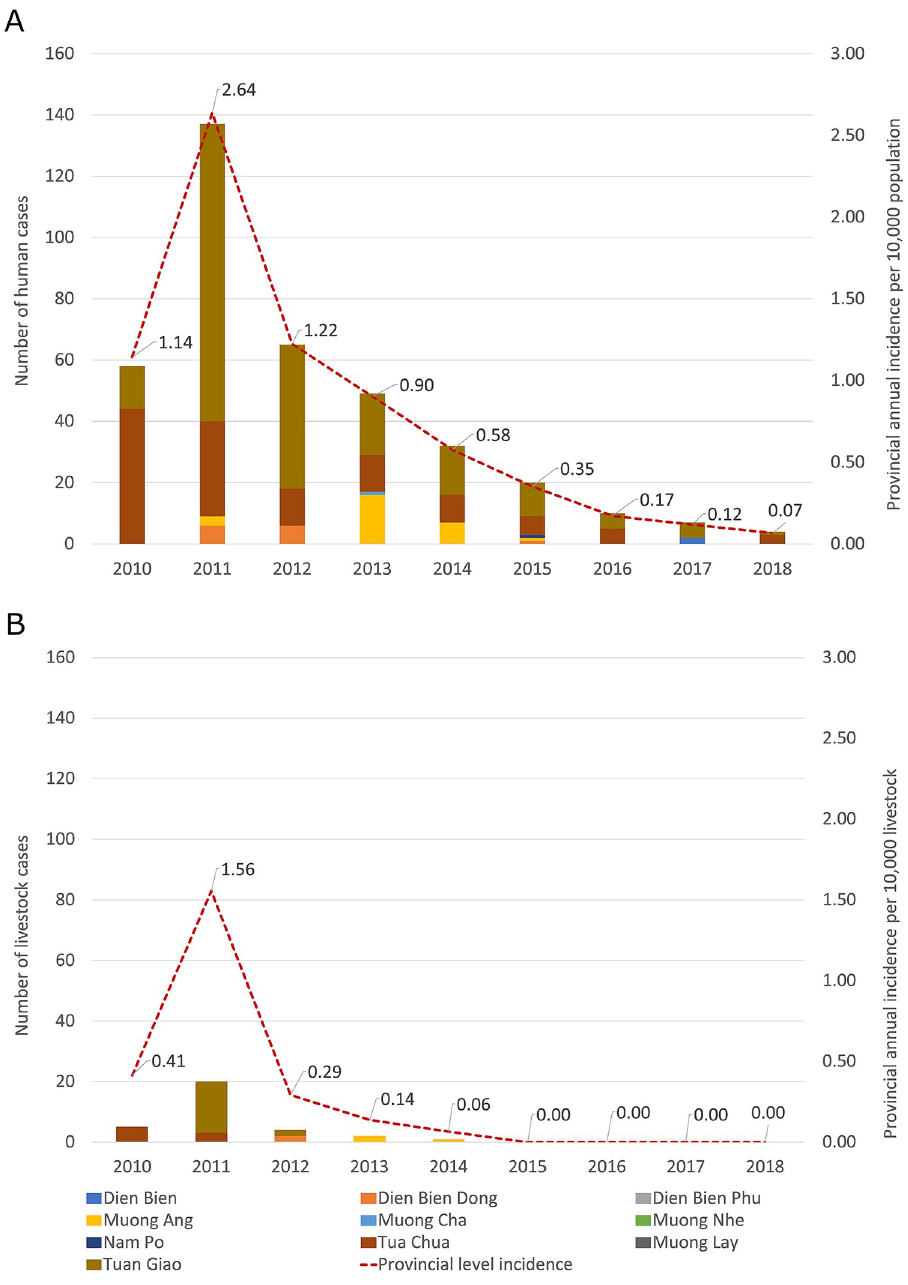
Fig 4. Annual trend of anthrax in human (A) and livestock (B) at provincial level and contribution of each district to the trends (2010–2018), Dien Bien province, Vietnam. infection. The remaining cases had unidentified sources or were suspected to be from environ- mental contamination. Fig 6 indicates the overlap between human and animal anthrax in the east and southeast regions of Dien Bien province. The communes with higher incidence of human anthrax were seen in districts with higher incidence of anthrax in livestock ( > 7–10 cases per 10,000 live- stock) (Fig 6A). However, anthrax in livestock was reported with very low incidence in some